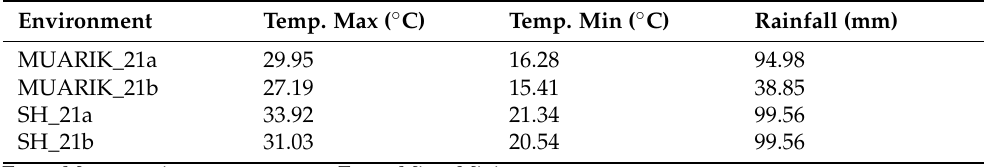
Table 2. Average monthly temperature ( ◦ C) and rainfall (mm) during the experiment seasons.